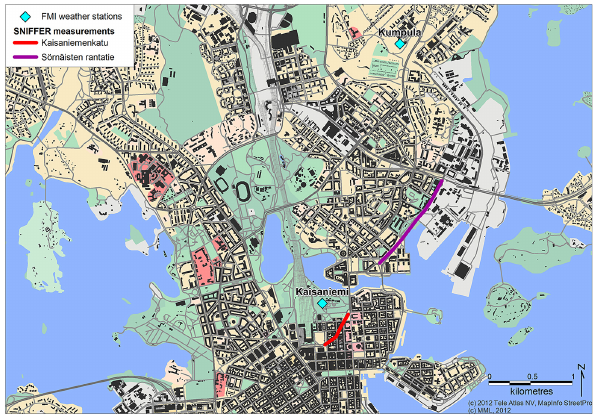
Figure 1. The locations of the street segments (Kaisaniemenkatu, the red line, and Sörnäisten rantatie, the violet line), in which the measurements were conducted, and the weather stations (green di- amonds) in central Helsinki in 2007 and 2008 (Kaisaniemi and Kumpula). Buildings are marked in black, parks are presented in green, urban and industrial areas in light brown and grey, and spe- cial sites, such as hospitals, in